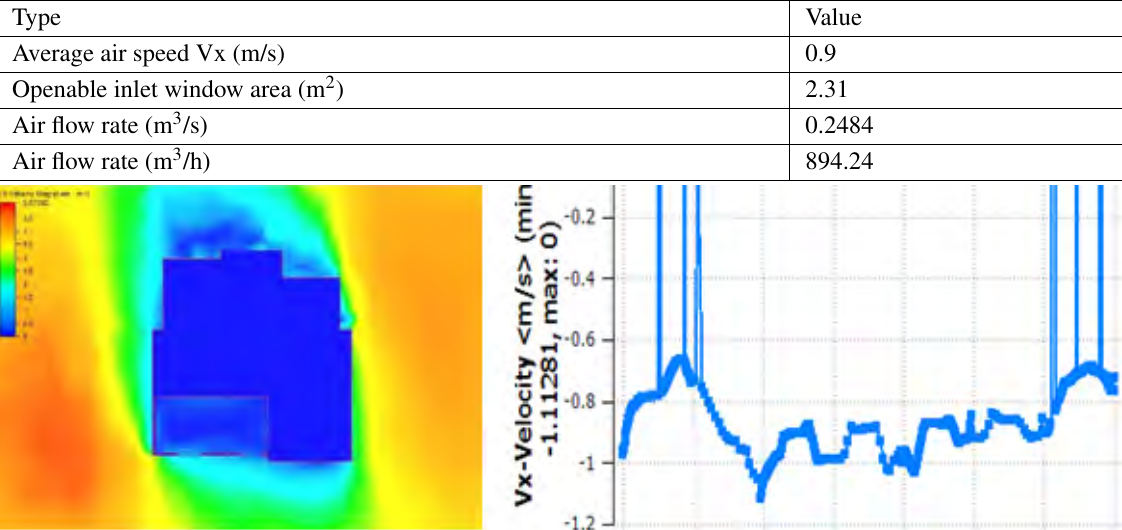
Figure 6. The air flow distribution outside and inside the master bedroom (left), the V x velocity normal to the inletwindow (right)